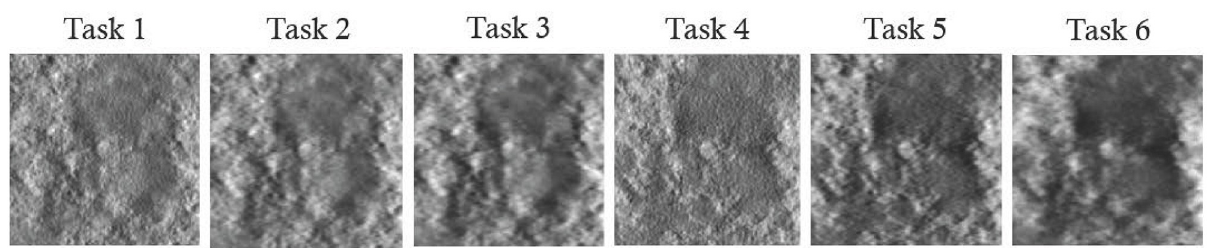
Fig 10. Exampled of reconstructed breast images. Examples of reconstructed in-plane images containing a 1mm diameter signal for all tasks. The display window is set by [min max] mm − 1 for each task to visualize the background structures more clearly.